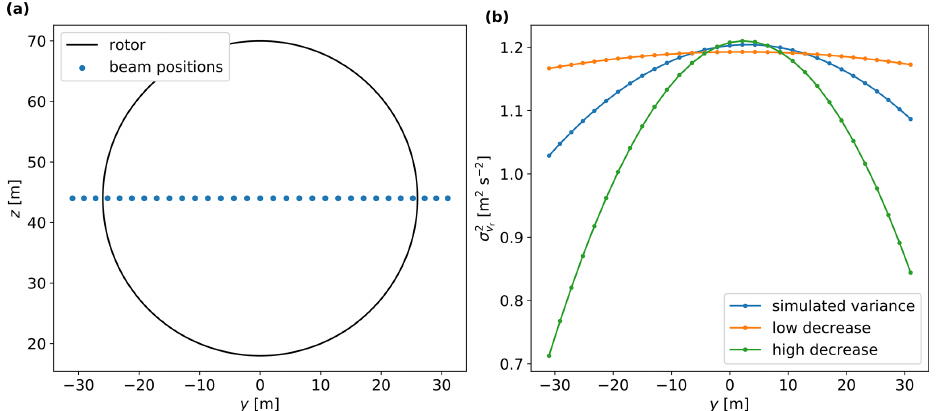
Figure 17. (a) Scanning pattern of a nacelle lidar with beams across the rotor. (b) The radial velocity variances of the beams across the rotor from simulations using five turbulence boxes.